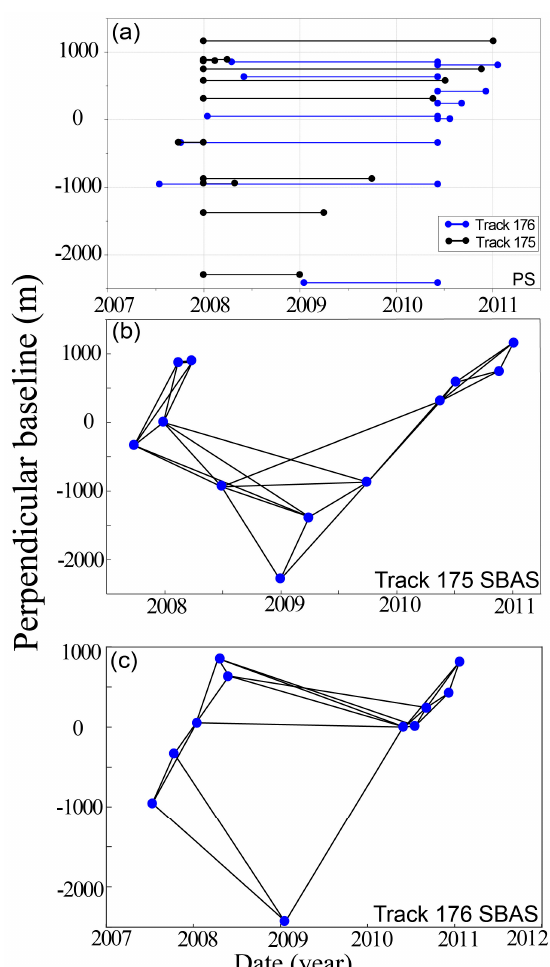
Figure 2. SAR interferograms spatial-temporal baseline distributions: ( a ) shows PS-InSAR (single master) interferograms of both two tracks: blue segments indicate 11 interferograms generated by ALOS path 175, with 20071227 as the master image; black segments represent 10 interferograms generated by ALOS path 176, with 20100605 as the master image; ( b , c ) SBAS (multiple master) interferograms with temporal and perpendicular baseline thresholds of 350 days and 1200 m, respectively.